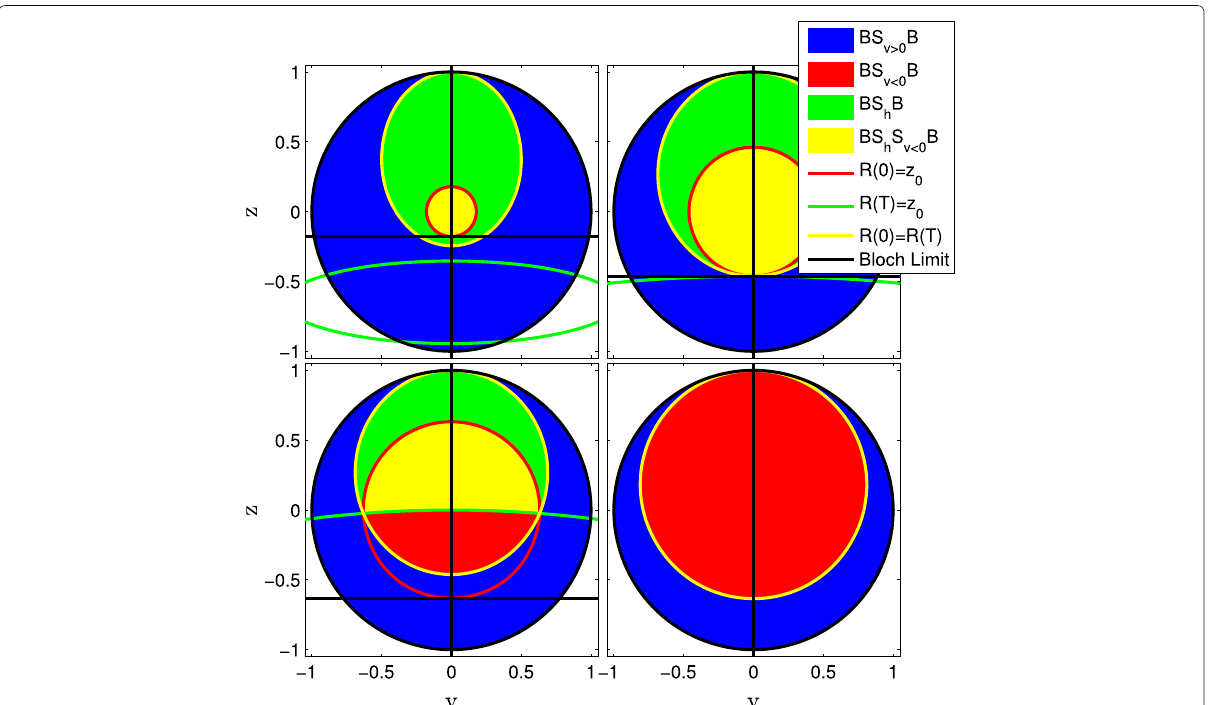
Fig. 4 (Color online) (Color online) Plot in the top-left and bottom panels of three possible steady-state syntheses. The synthesis in the top right is the transition from the top-left to the right-left cases. The parameters ((cid:6) , γ) are respectively taken to be (1.90,0.5), (1.80,1), and (1.69,1.5), from top to bottom and left to right. The color code and the small insert indicate the control law used according to the position of the M point in the Bloch ball. The Bloch limit represents the circle of equation y 2 + z 2 = 1. The times 0 and T correspond respectively to the initial and final times of the control field. The different quantities are unitless. The different quantities are